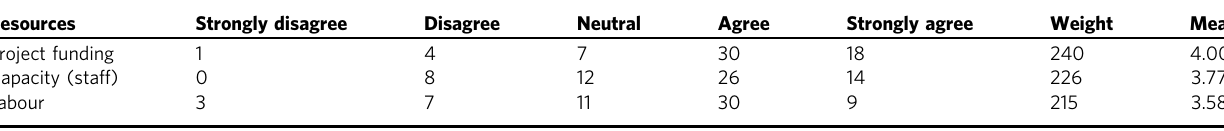
Authors ’ fi eld construct